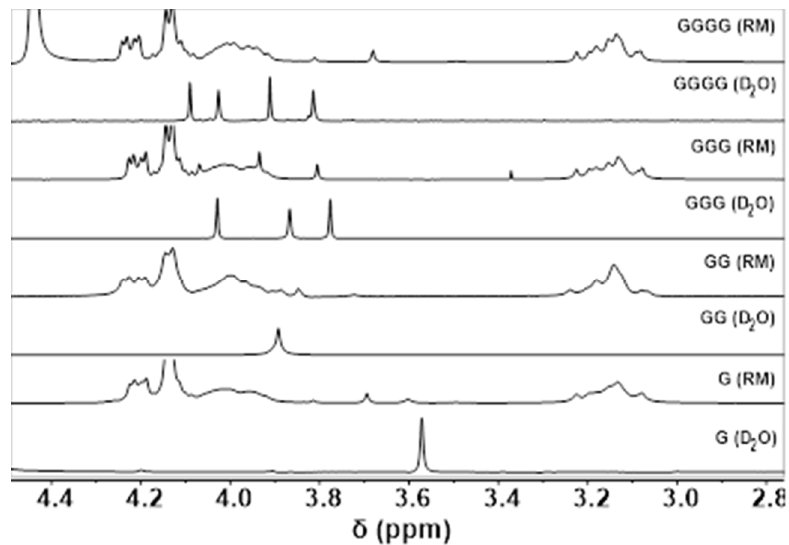
Figure 8. A comparison of each of the studied compounds and their chemical shifts as determined by 1 H NMR in w 0 10 reverse micelles (RMs) and D 2 O. Spectra beginning from the bottom correspond to G, GG, GGG, and GGGG in D 2 O and RM alternately at pH 7. Asterisk in the GGG RM spectrum denotes acetone impurity.